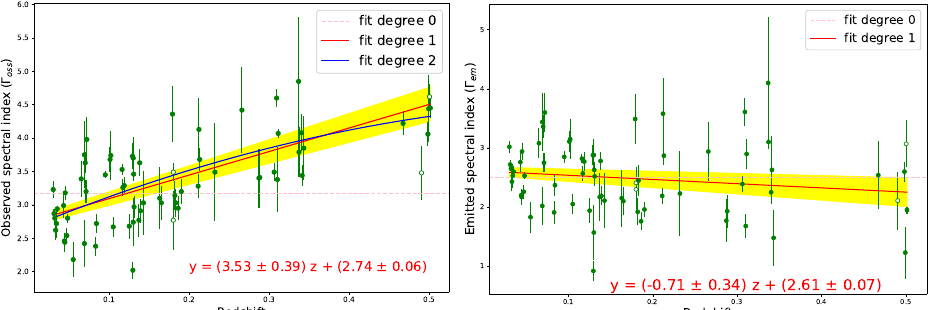
Figure 8. Left panel : Values of the observed spectral indices Γ obs for the blazar sample analysed by [128], versus redshift. Fits with different polynomials are indicated. Right panel : Same as on the left panel, but after correction for EBL absorption following [82] ( Γ em ). The red continuous curve is the best-fit regression line to the data, showing a modest redshift